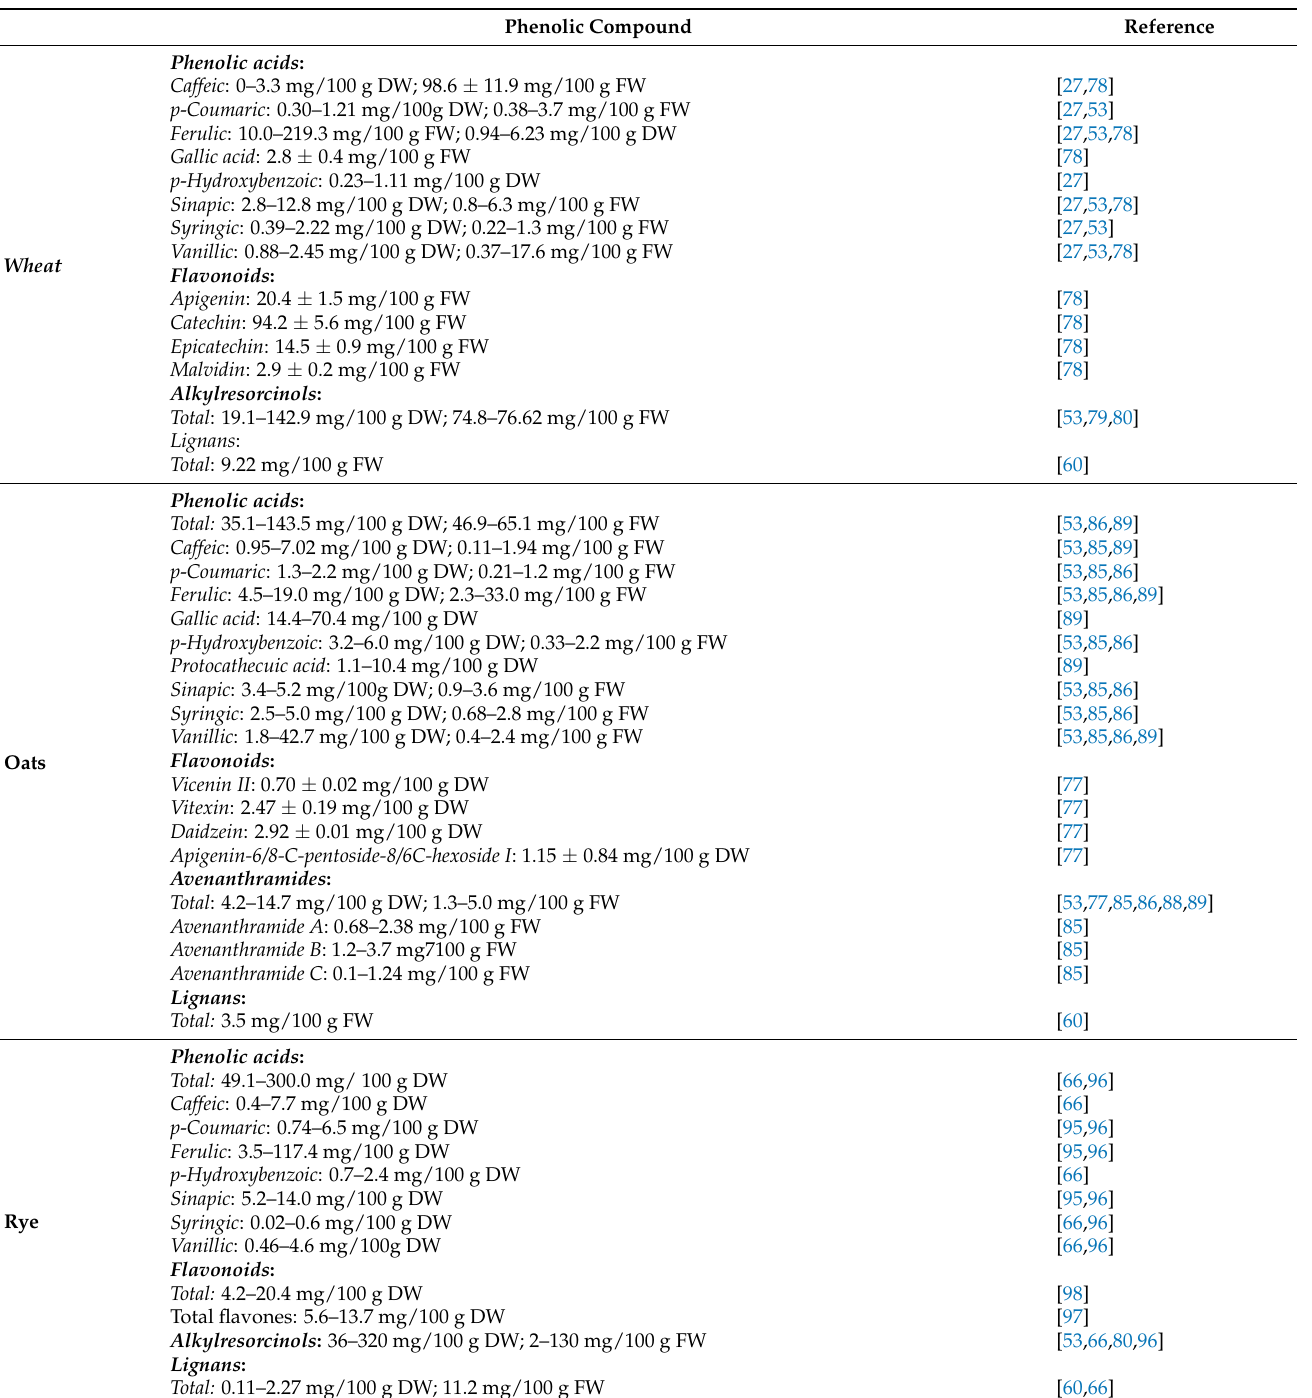
Table 1. Cont . Phenolic Compound